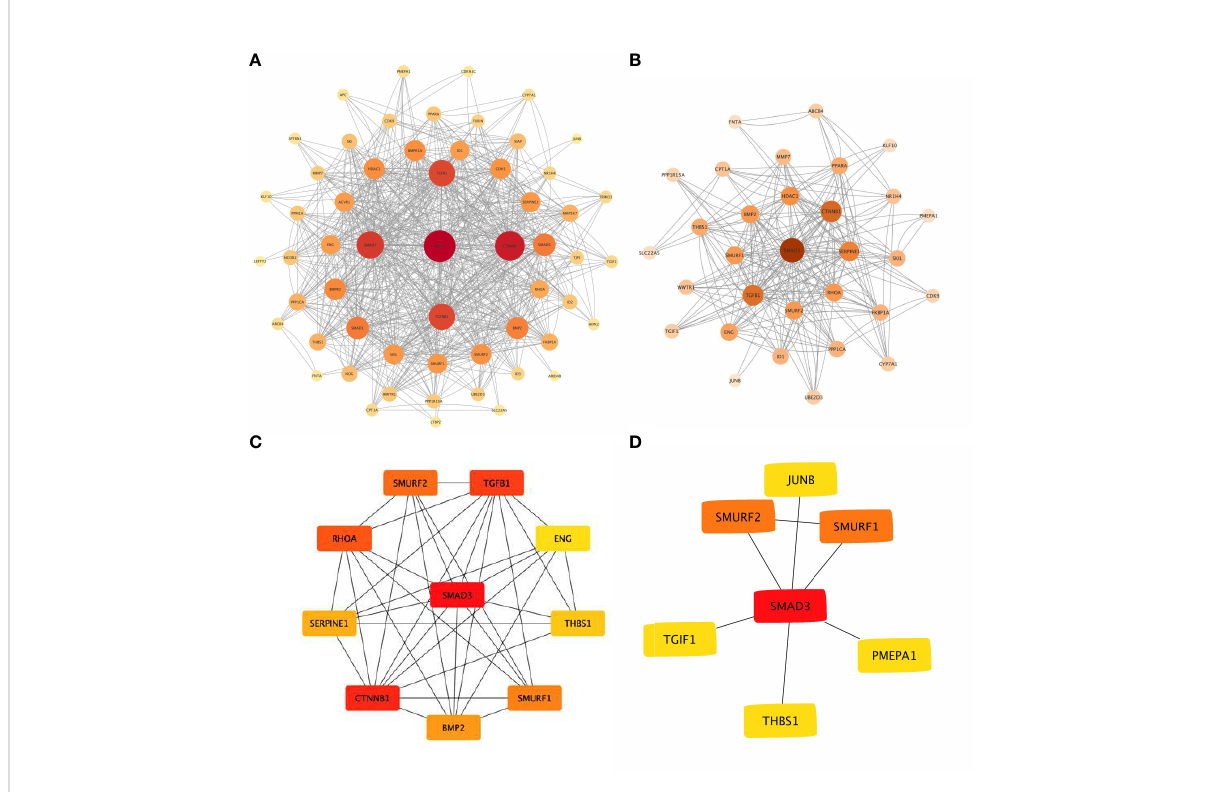
FIGURE 3 Protein-protein interaction network of TGF b pathway (A) TGF b pathway and PPAR a , NR1H4, and other proteins. (B) GSEA of the TGF b pathway and the interaction with PPAR a , NR1H4, and other proteins based on the CORE ENRICHMENT results. (C) Hub gene screening with cytoHubba. (D) Common key genes in TGF b pathway.